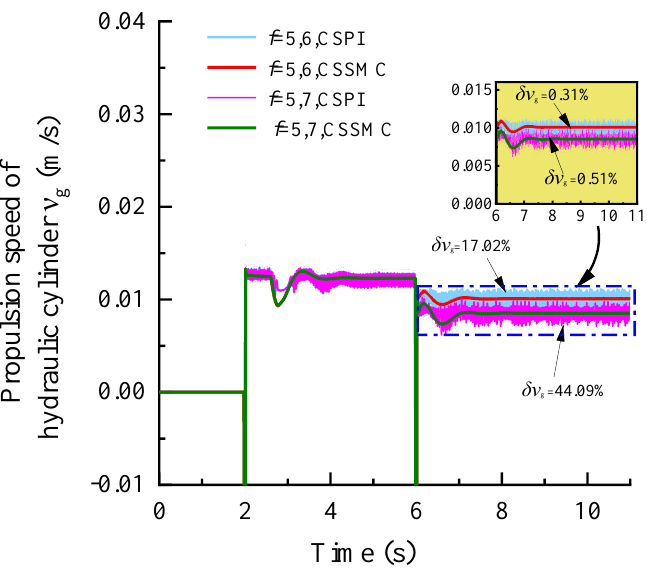
Figure 11. Variation curve of the hydraulic cylinder speed based on the CSPI and CSSMC. When the coefficient of rock hardness changes abruptly from f = 5 to f = 6, the hydraulic pump outlet pressure of the pump-controlled motor system based on the CSPI fluctuates the most, with an overshoot of 67.87%, while the pulsation coefficients of pressure, motor speed, and hydraulic cylinder propulsion speed after entering the steady state become 5.87%, 1.32%, and 17.02%, respectively. By the CSSMC, the hydraulic pump outlet pressure, the speed of hydraulic motor, and the speed of hydraulic cylinder are 0.39%, 0.18%, and 0.31%, respectively (see Figures 9–11). When the rock hardness coefficient is abruptly changed from f = 5 to f = 7, the parameters of the hydraulic control system change in a similar pattern, which will not be repeated here. To further compare and analyze the pulsation of each physical quantity after the system enters the steady state in Figures 6–11, the statistical results are shown in Table 2. Table 2. Pulsation analysis of the CSPI and